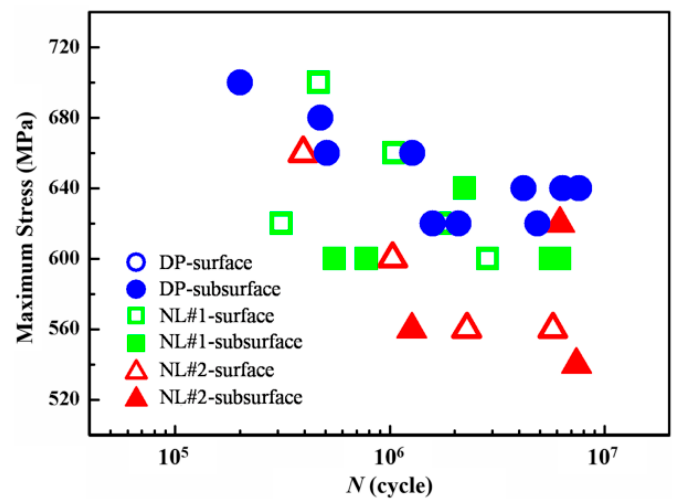
Figure 6. The variation of crack nucleation sites for different TNM alloys in the S - N space.